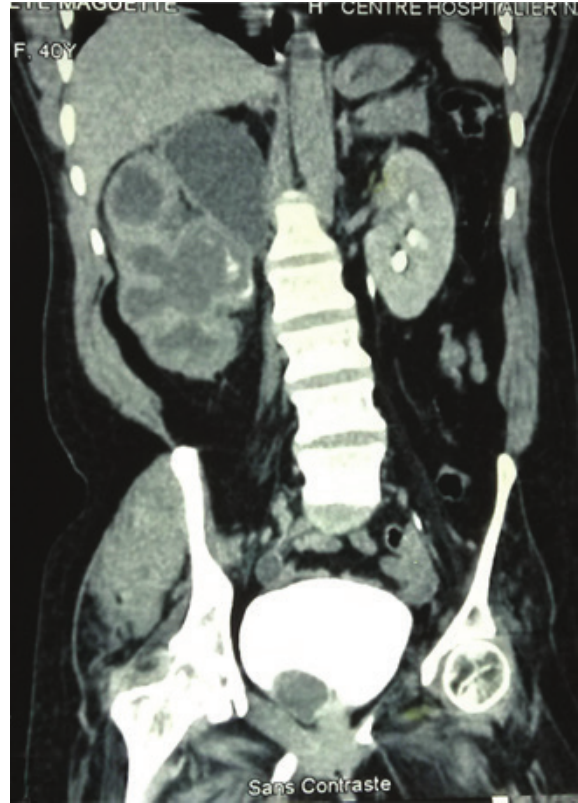
Figure 2: A contrast CT-scan showing a cystic right renal tumor in the upper pole with associated hydronephrosis. Courtesy: Grand Yoff